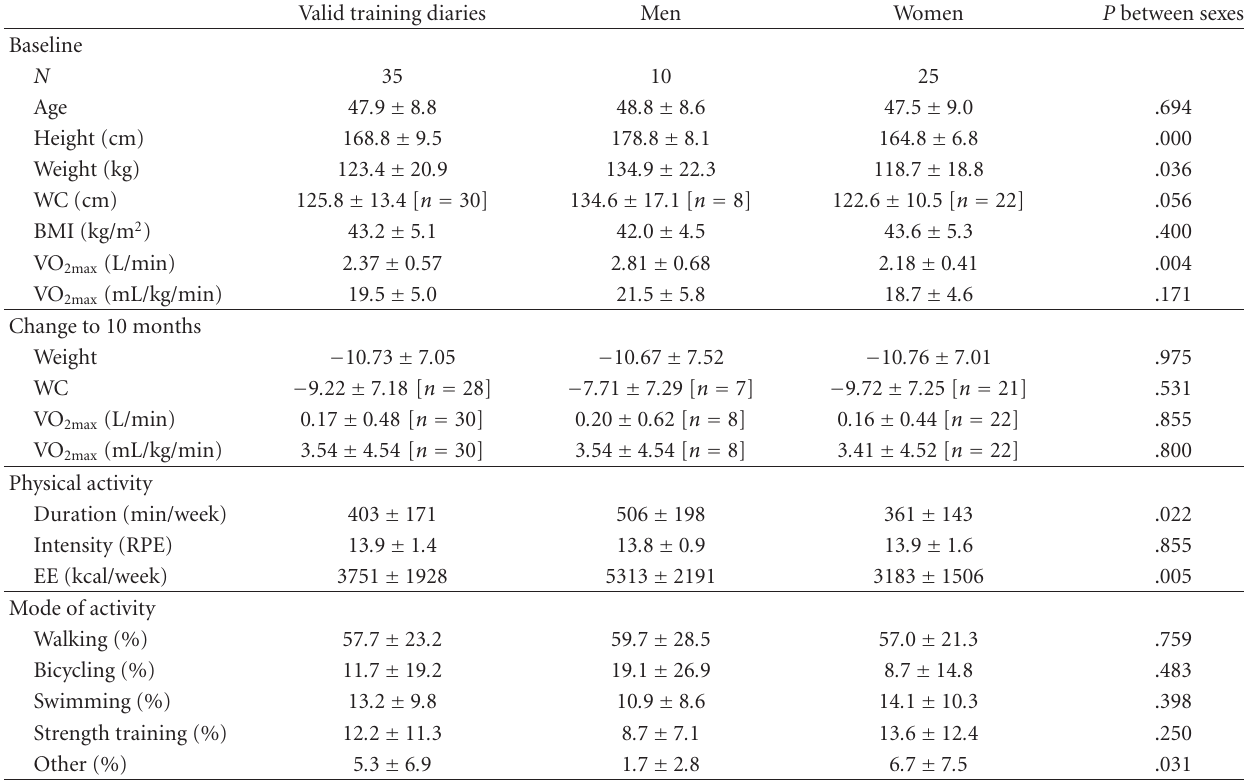
Table 1: Baseline characteristics and change values for the group with valid training diaries. (Mean ± SD n ; when di ff erent from the total in each group). WC: waist circumference; BMI: body mass index; VO 2max : estimated maximal oxygen consumption; EE: energy